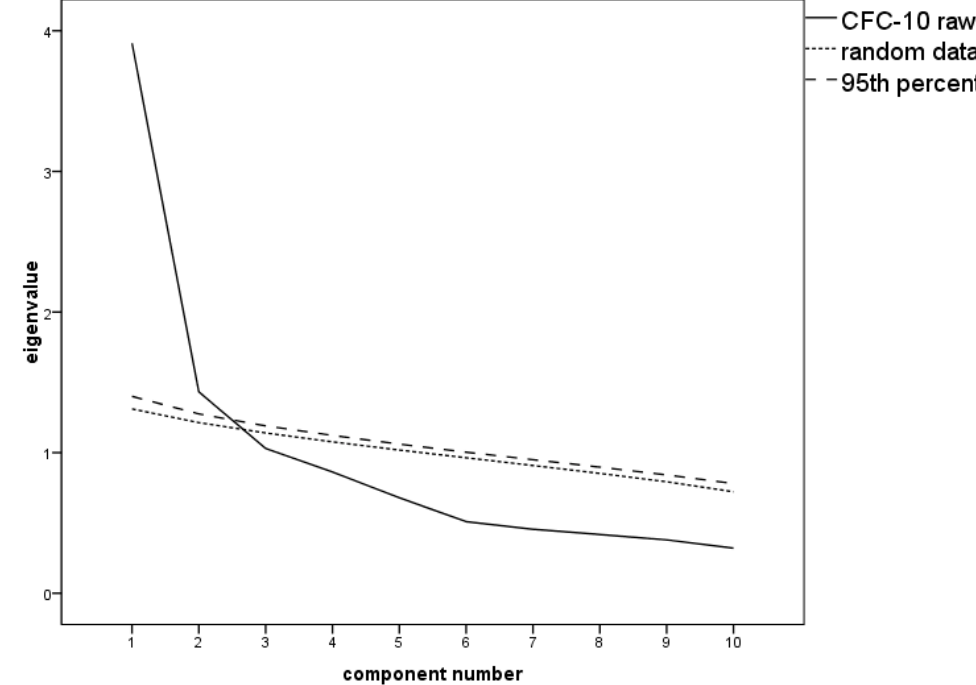
Figure 2. Scree plot with the parallel analysis of the Consideration of Future Consequences Scale (CFC-10) suggesting two factors to be extracted.